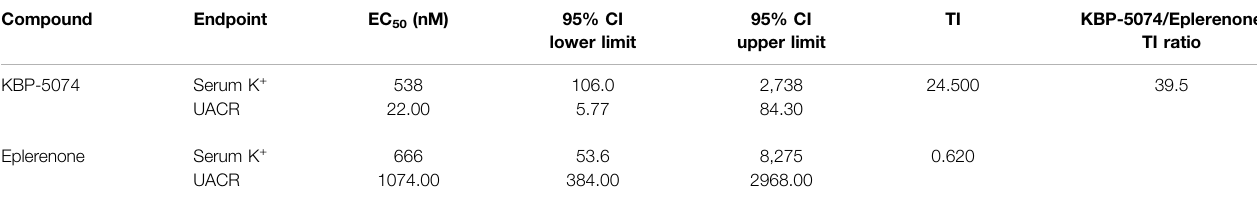
TABLE 4 | Effect of eplerenone and KBP-5074 on UACR and serum K + . Compound